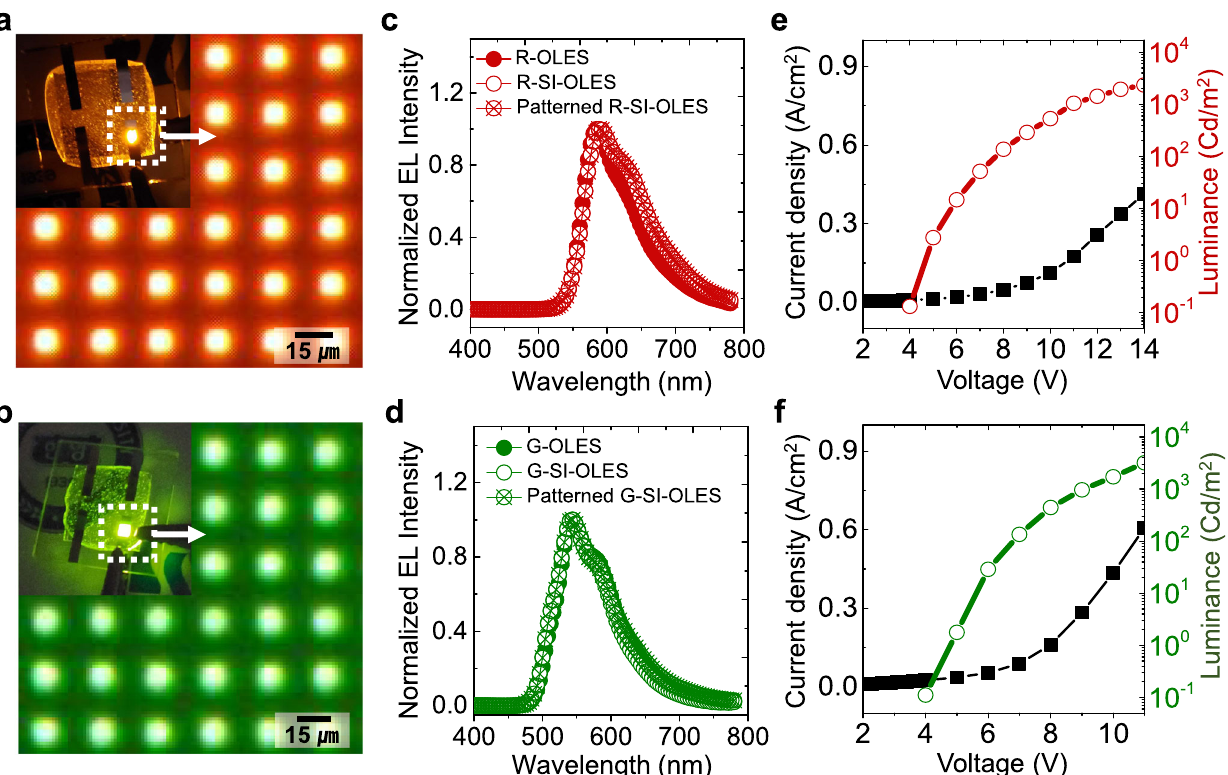
Fig. 3 | EL characteristics of high-resolution pixelated R- and G-SI-OLEDs. a , b Opticalmicroscopyandphotographyimages(inset)ofelectricallyoperatingR- and G-SI-OLEDs. c , d EL spectra of the R- and G-SI-OLESs before and after